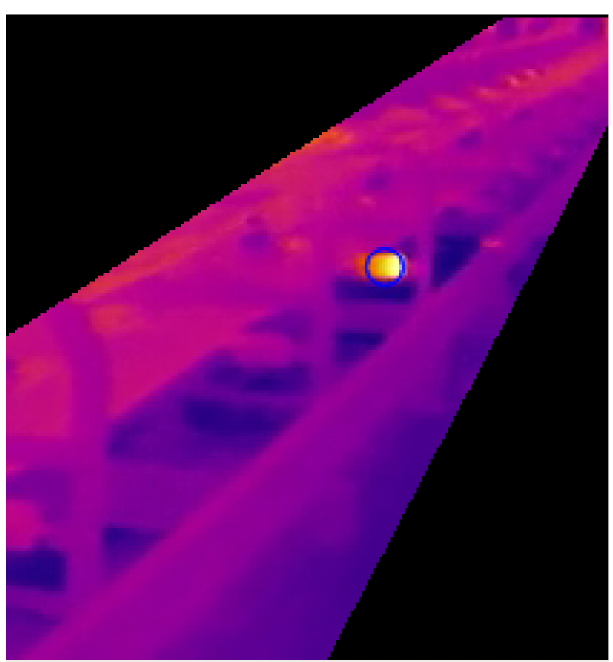
Figure 18. Possible effect of applied predetermined mask